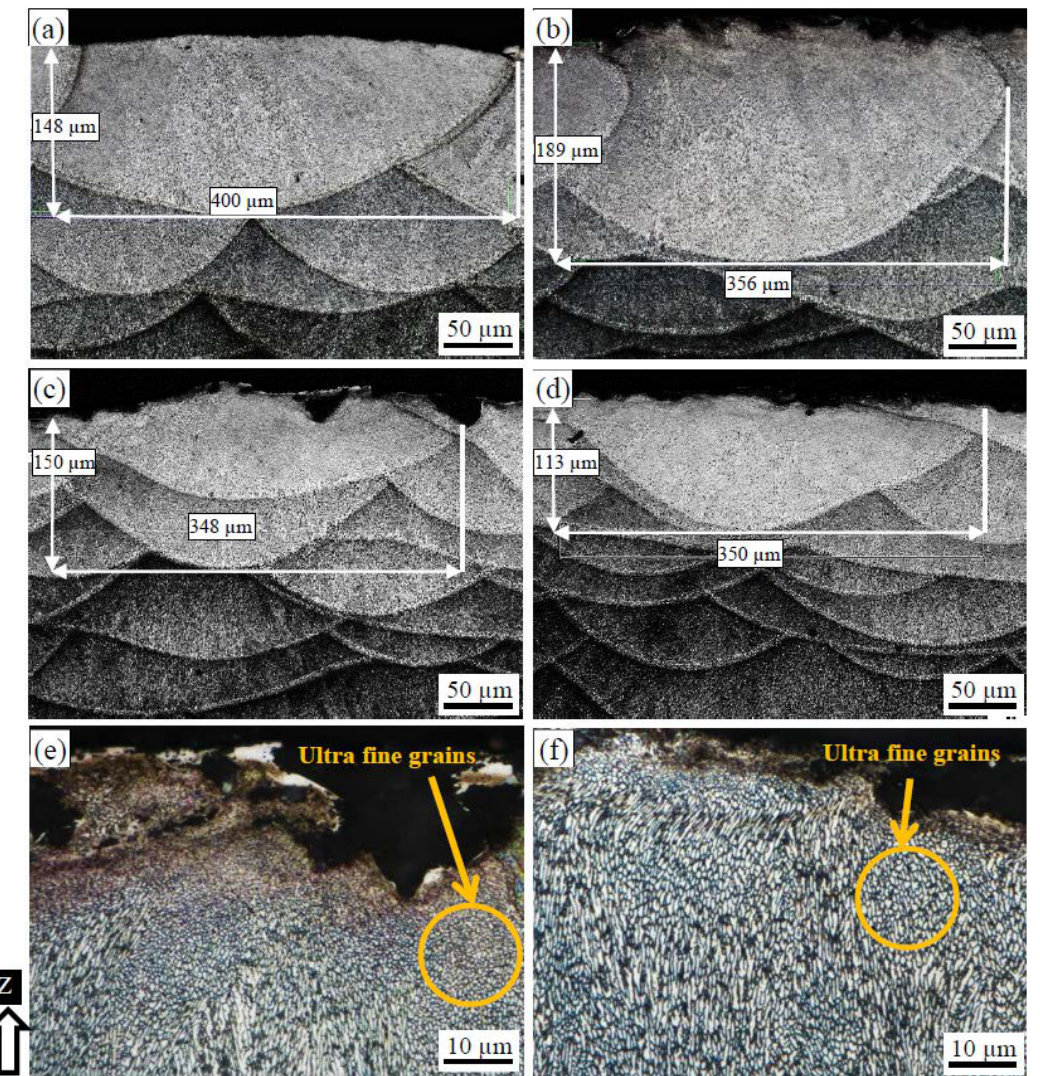
Figure 7. The influence of shot peening on the melt pool shape of the AlSi10Mg sample, ( a ) AB, ( b ) AB + SP, ( c ) M + HSP ( d ) M + LSP, and a surface profile at high magnification; ( e ) M + HSP, ( f ) M + LSP.